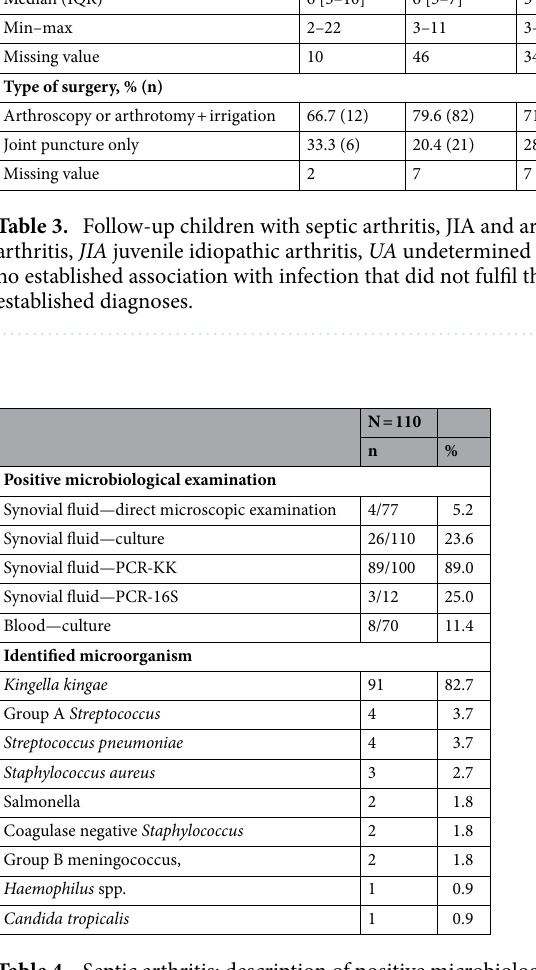
Table 4. Septic arthritis: description of positive microbiological examinations and identified microorganisms. PCR-KK: PCR for Kingella kingae